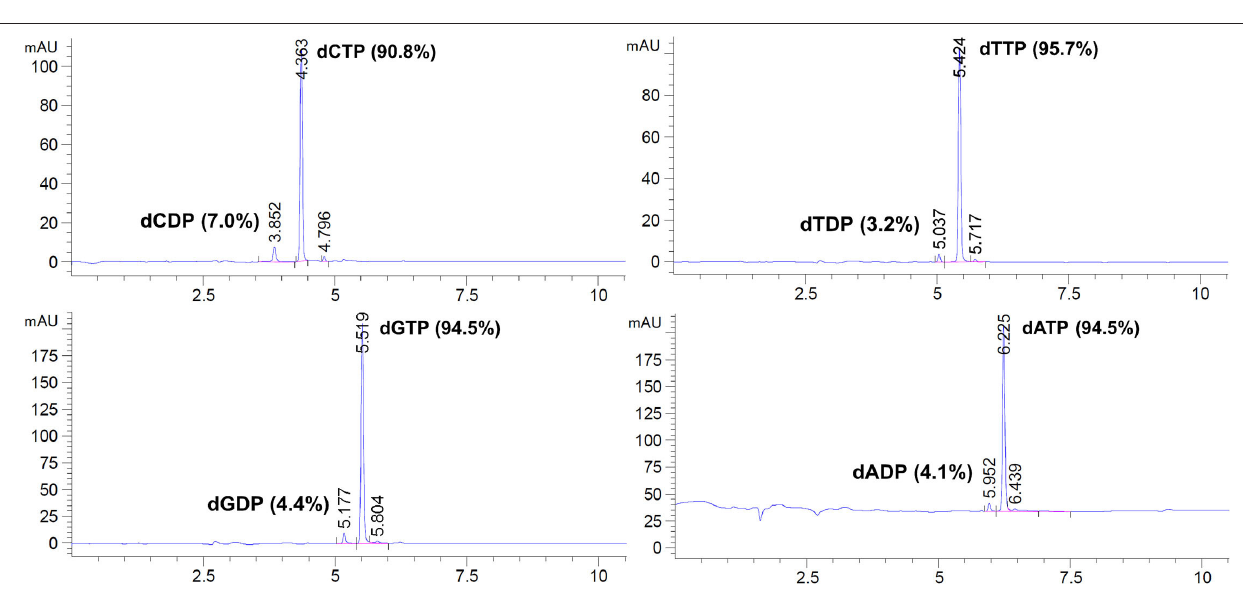
FIGURE 3 | dNTP purity analysis by HPLC UV peak area at 260nm. Method: C18 column (Agilent Poroshell 120 EC-C18, 2.7 µ M, 100 × 4.6mm), linear gradient of 0–15% MeCN in 50mM aqueous triethylammonium acetate (pH 7.0) with 2mM EDTA over 10min at a flow rate of 1.0ml min − 1 . The retention times of the peaks (in minutes) are shown on the x axes, and the peak intensities in milli-absorbance units (mAU) at 260nm are shown on the y